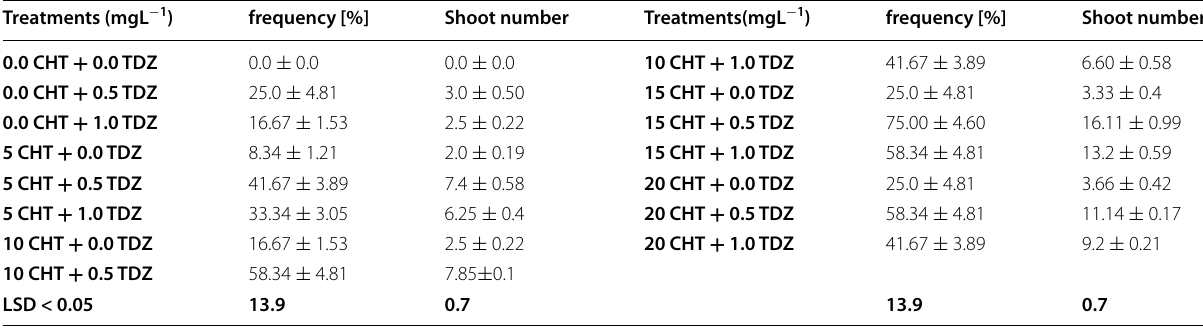
Table 3 Effect of chitosan (CHT) and thidiazuron (TDZ) on a response percentage (%) of callus for bud formation, and a number of buds/100 mg callus for date palm, cv. Barhee after 12 weeks of